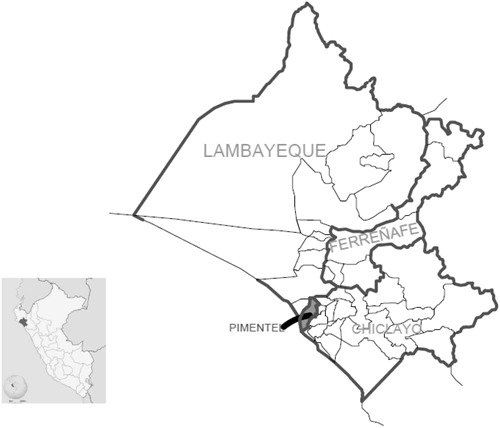
Map of the study area.